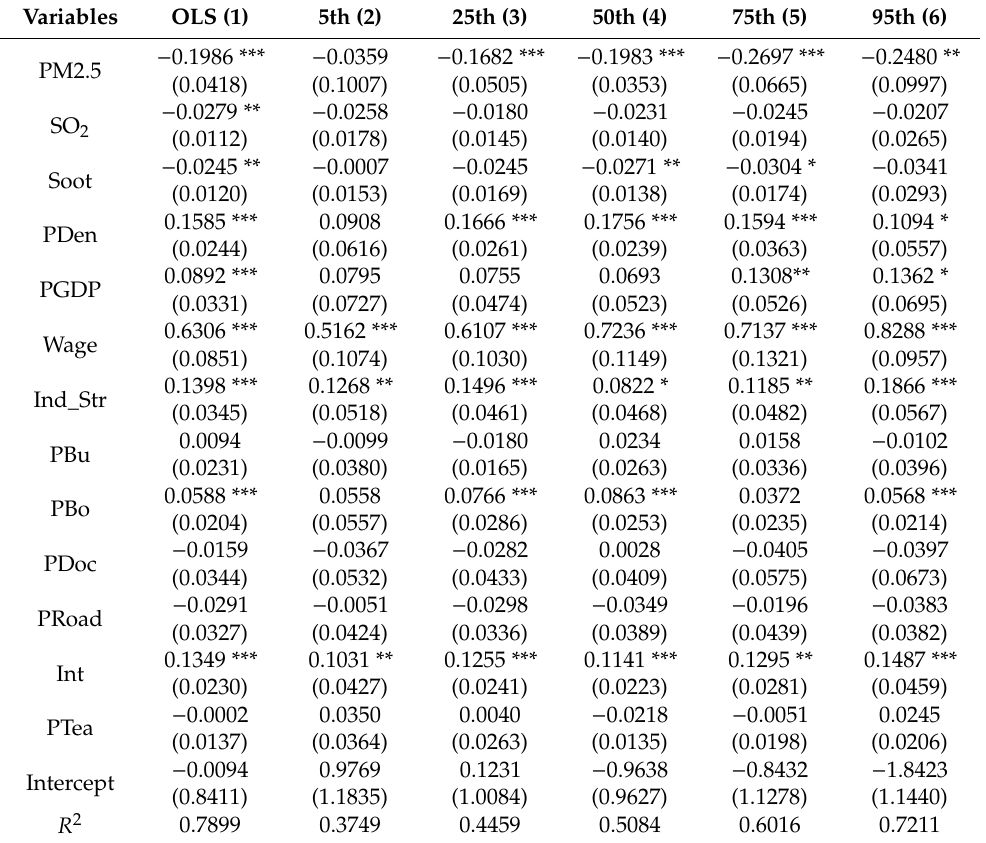
Table 2. Ordinary least squares (OLS) and quantile regression results for